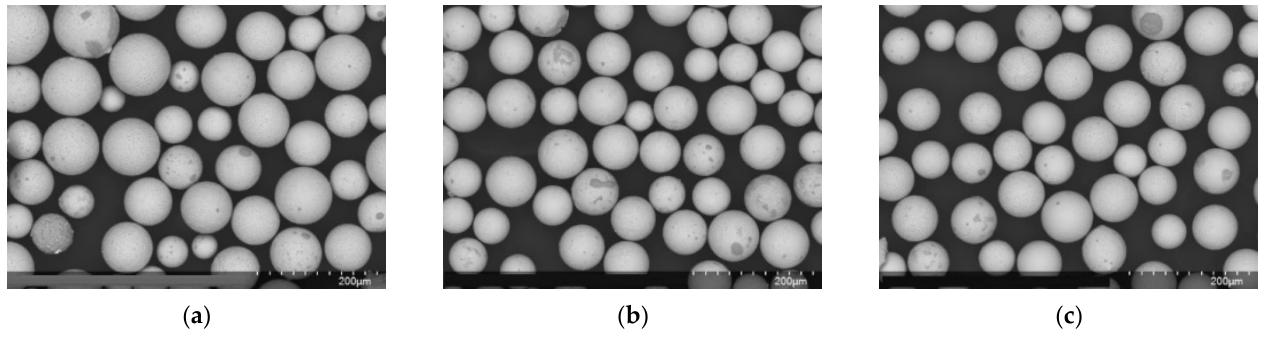
Figure 7. SEM of powder particles obtained by plasma atomization with a × 200 magnification ( a )—No. 1 (316L stainless steel), ( b )—No. 2 (+ 0.2% AG), and ( c )—No. 3 (+0.5% silver). The fluidity and bulk density of powders were measured by a Hall flowmeter in accordance with GOST 19440-94 and GOST 20899-98. The measurement results of the obtained powders are shown in Figure